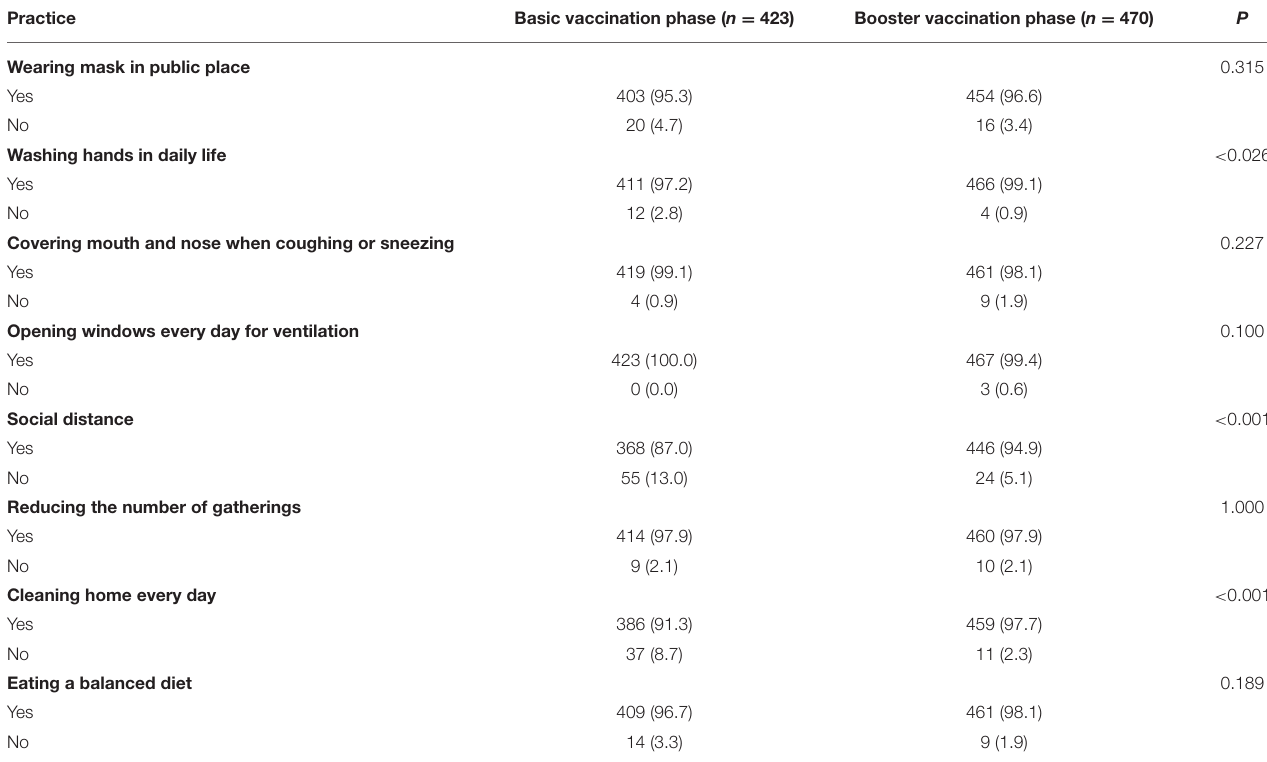
TABLE 4 | Comparison of protective behaviors toward government measures between two surveys. Practice Basic vaccination phase ( n = 423) Booster vaccination phase ( n =